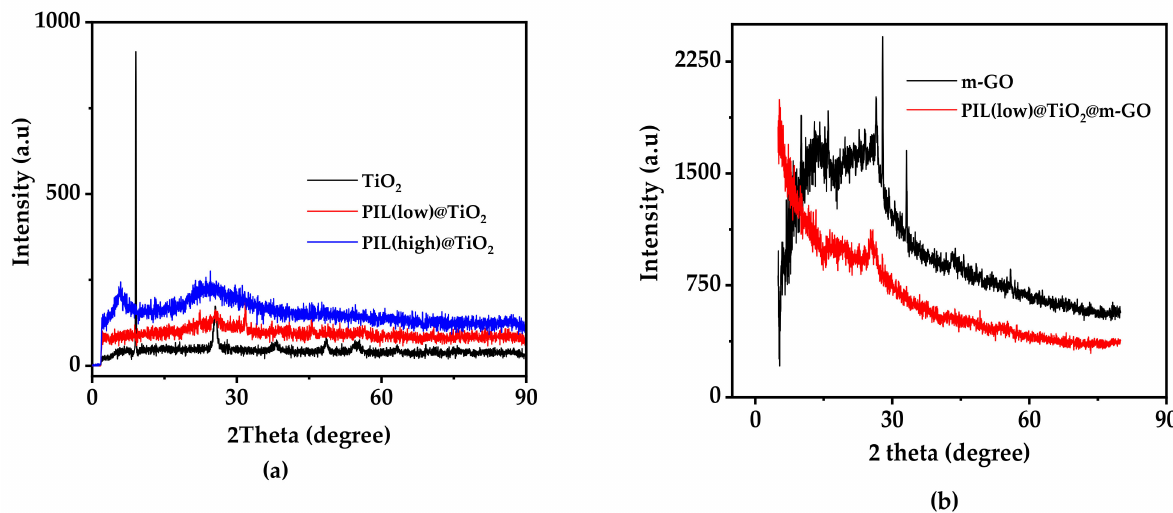
Figure 2. XRD pattern of ( a ) TiO 2 , PIL(low)@TiO 2 , PIL(high)@TiO 2 , ( b ) m-GO, and PIL(low)@TiO 2